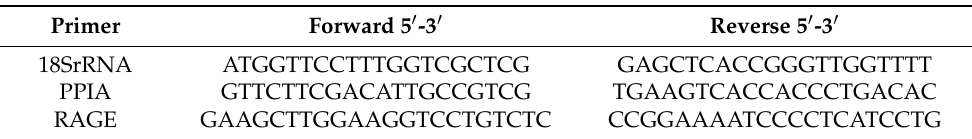
Table 1. Applied primer sequences for 18SrRNA, Peptidylpropyl Isomerase A (PPIA) and Receptor for Advanced Glycation End Products